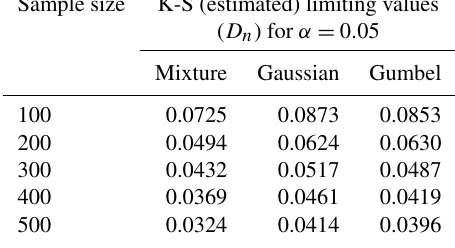
Table C1. Estimated limiting values (for α = 0 . 05) for the Kolmogorov–Smirnov goodness of fit test for the three distribu-